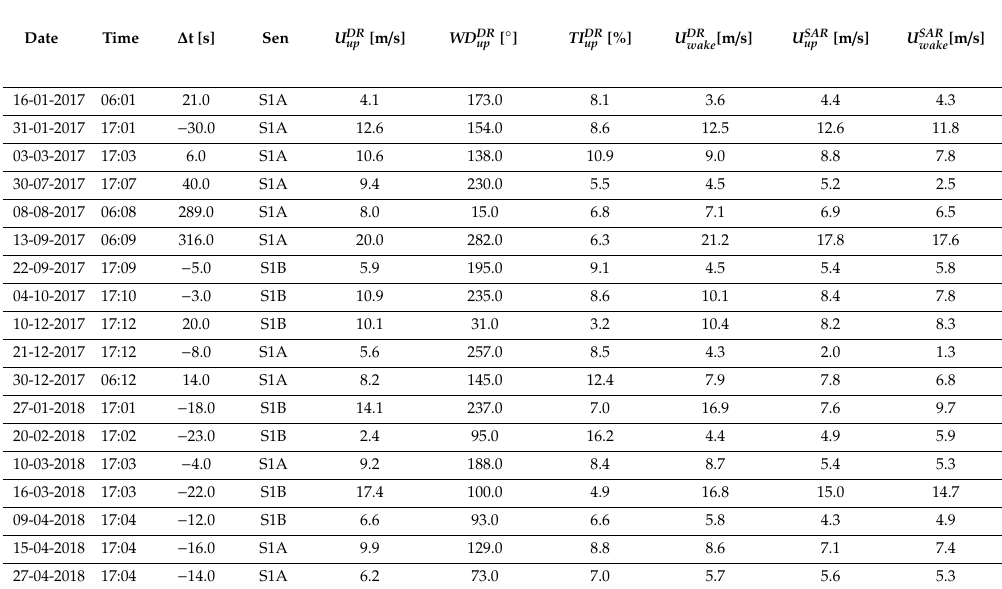
Table 1. Overview of Doppler radar measurements co-located with SAR images. All Doppler radar winds in the table are measured at 100 m. ∆ t is the time di ff erence between Doppler radar scan and SAR image and “Sen” denotes the SAR